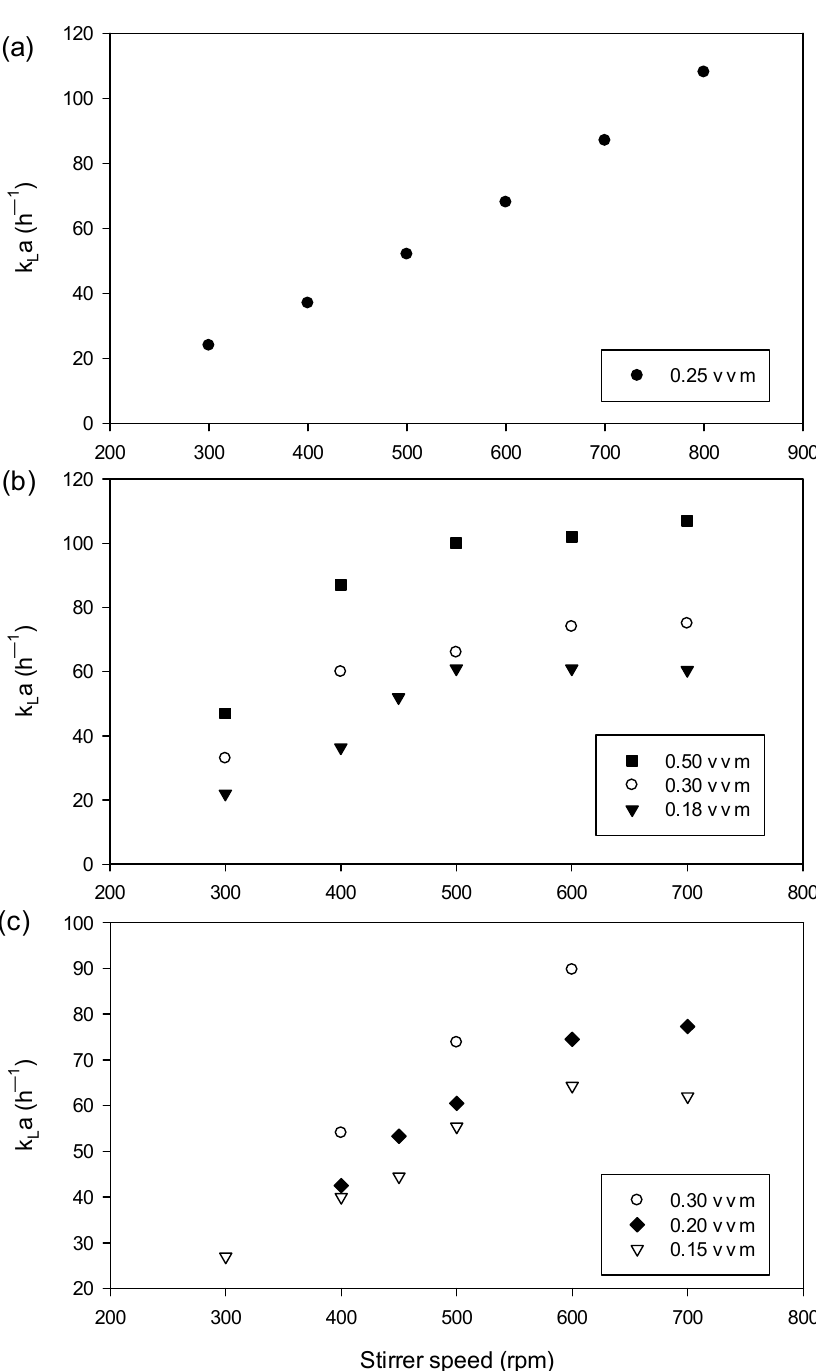
Figure 1. Comparison of the oxygen mass transfer coefficient (k L a) as a function of stirring speed (rpm) and aeration rate (vvm) in different size stirred-tank fermenter systems: ( a ) 1.5 L bench-scale, working volume (WV): 0.8 L; ( b ) 15 L bench-scale, WV: 10 L and ( c ) 75 L pilot-scale, WV: 35 L.